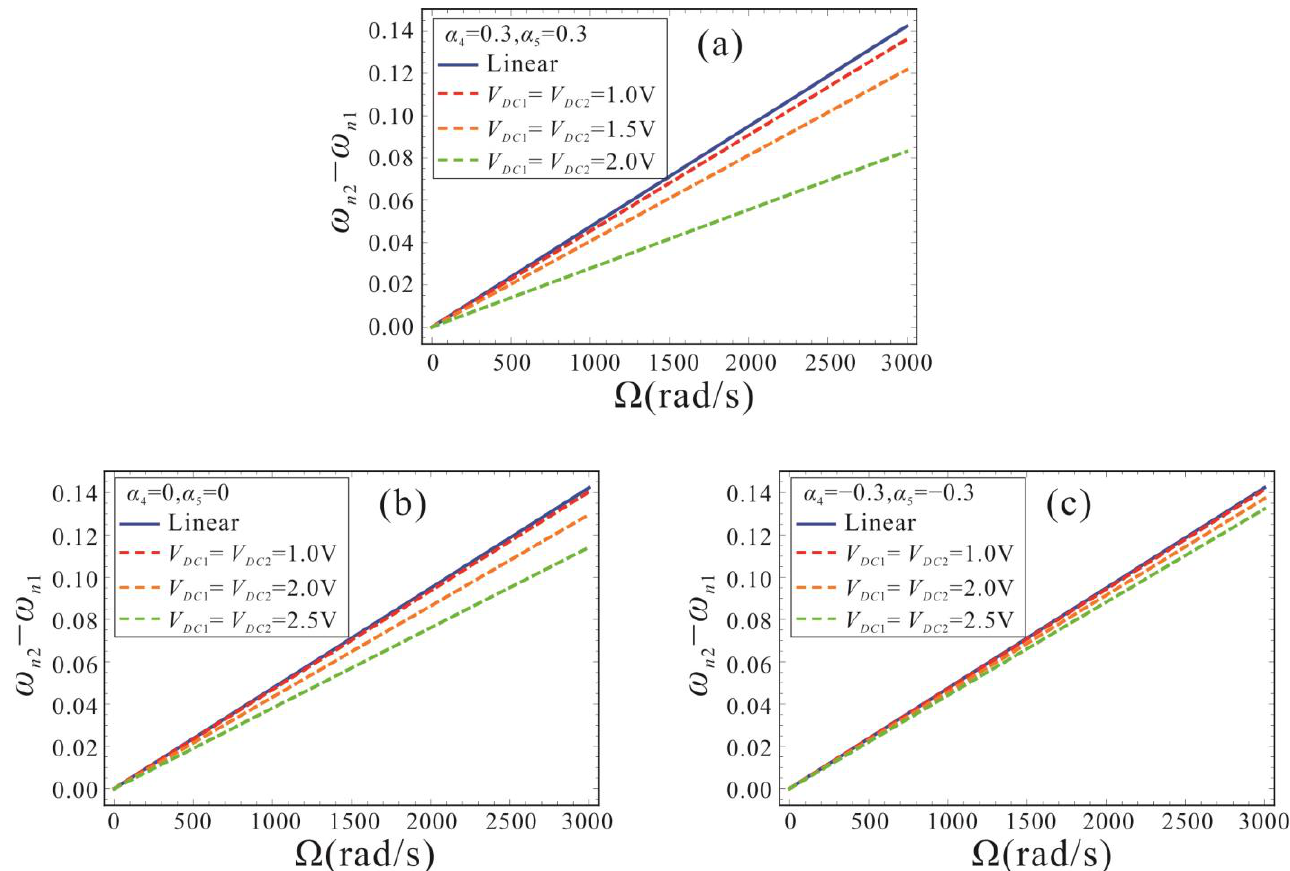
Figure 15. Sensitivity performance of micro-gyroscope with different bias DC voltage. ( a ): shape factors are α 4 = α 5 = 0.3; ( b ): shape factors are α 4 = α 5 = 0; ( c ): shape factors are α 4 = α 5 = −0 .3.